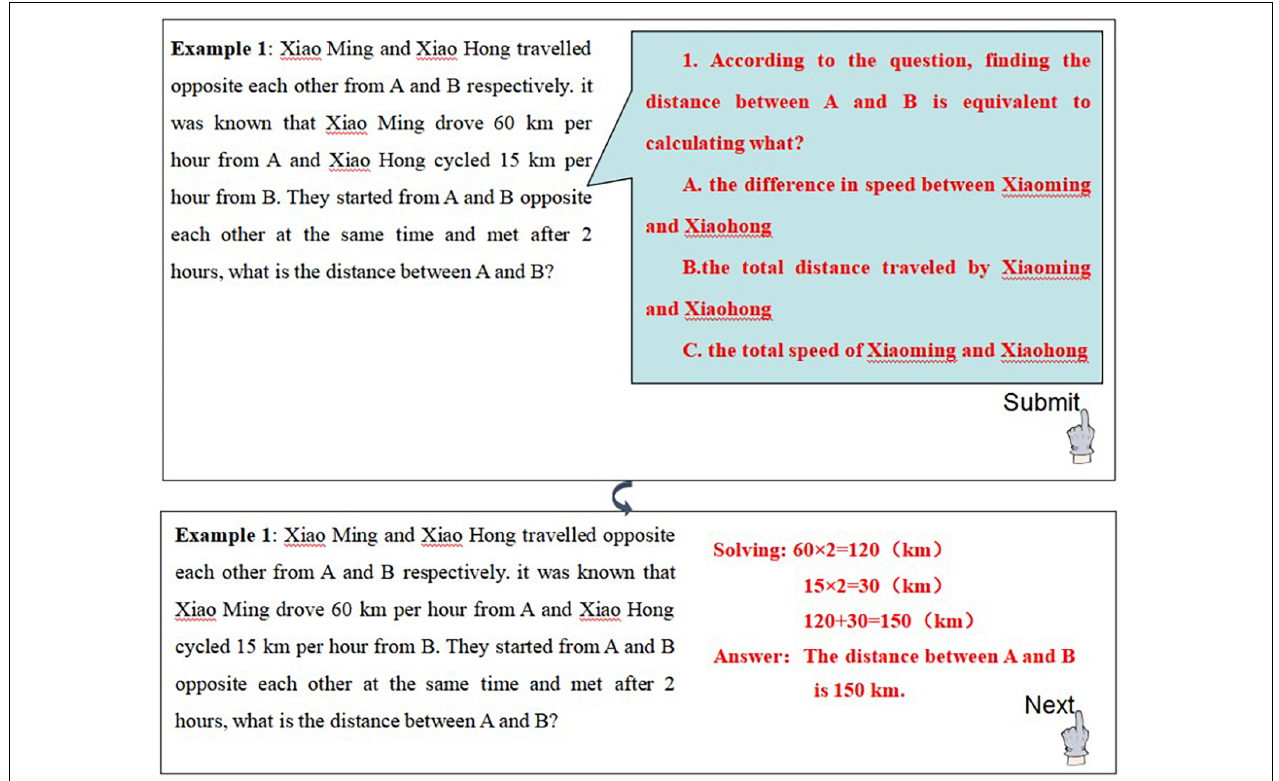
FIGURE 4 | Individual choice subgoal-labeled worked